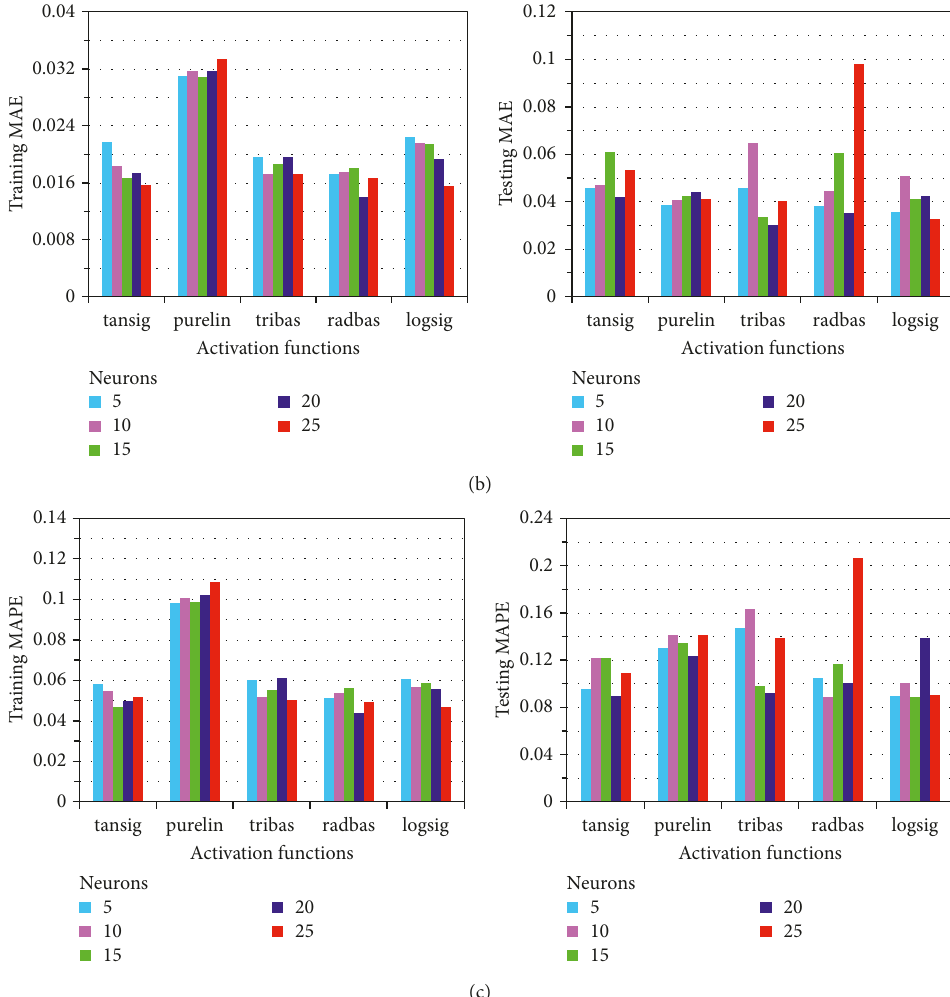
Figure 9: (a) RMSE, (b) MAE, and (c) MAPE performances of training and testing phases for thermal diffusivity.